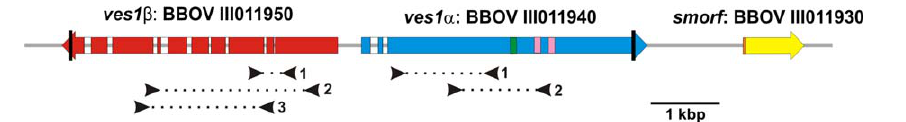
Figure 3. Diagram of a Locus Containing the ves1 a , ves1 b , and smorf Genes The genome backbone is a gray line, ves1 a exons are blue, ves1 b exons are red, and the SmORF exon is yellow. Introns are shown as blank boxes through which the genome backbone is seen. The systematic gene name for each gene is shown. Transmembrane helices (black bars), coiled-coil domains (green boxes), variant domains with conserved sequences 1 and 2 (pink boxes), and the SmORF signal peptide (orange box) are indicated. Arrows represent the positions of the primers for each of the cDNA experiments. The experiment number is indicated to the right of the primer sets, with experiment 1 targeting specific genes, experiment 2 sets of genes, and experiment 3 the published LAT.